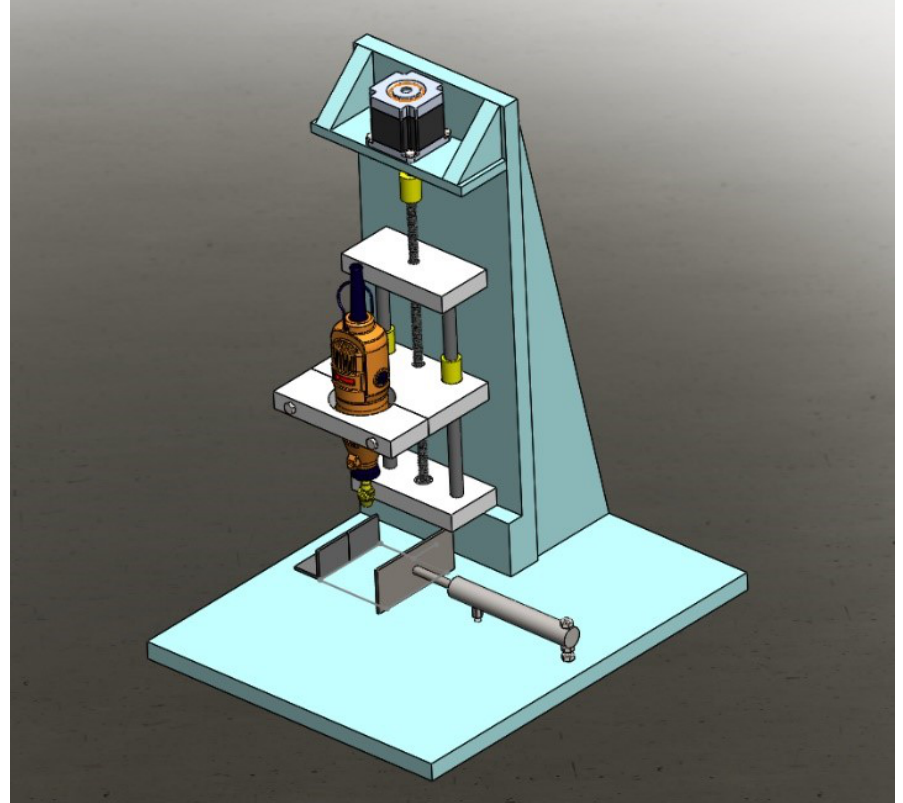
Figure 4. The proposed CAD model of the drilling